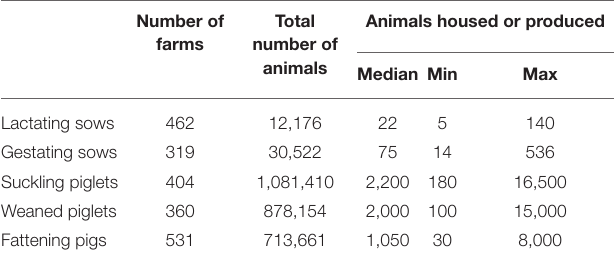
TABLE 1 | Number of farms out of the 893 study farms providing complete datasets of AMU for each age category; minimum (min), median, maximum (max), and the total number of animals of the respective age category on these